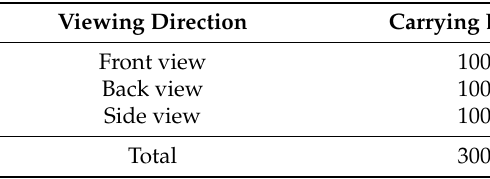
Table 1. PETA dataset